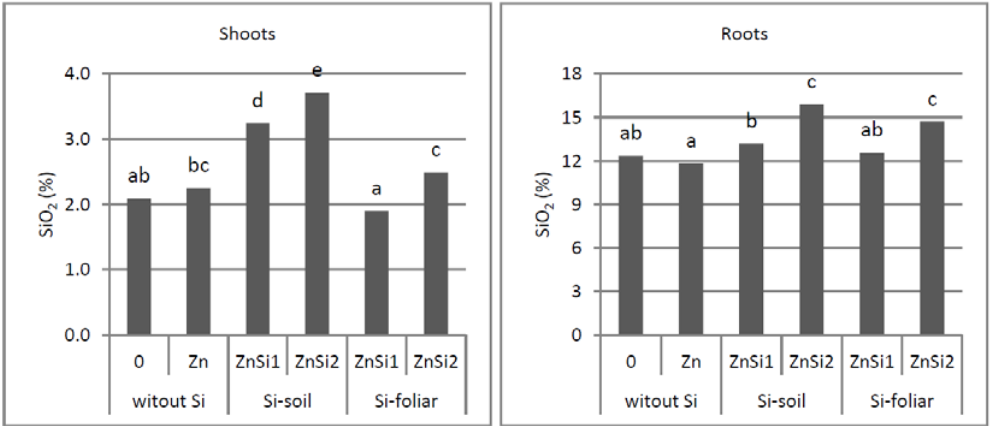
Figure 3. SiO 2 concentration in shoots and roots of wheat. Values marked with the same letters indicate no significant difference according to Tukey ’ s test ( p < 0.05).